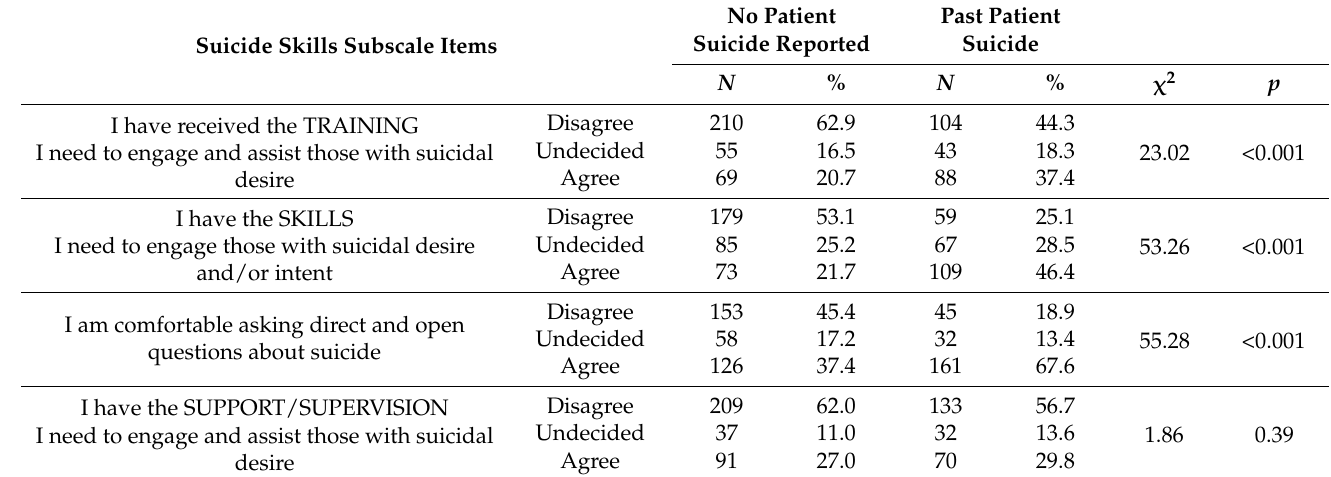
Table 2. Contingency table suicide skills subscale items: past experiences of patients’ suicide.